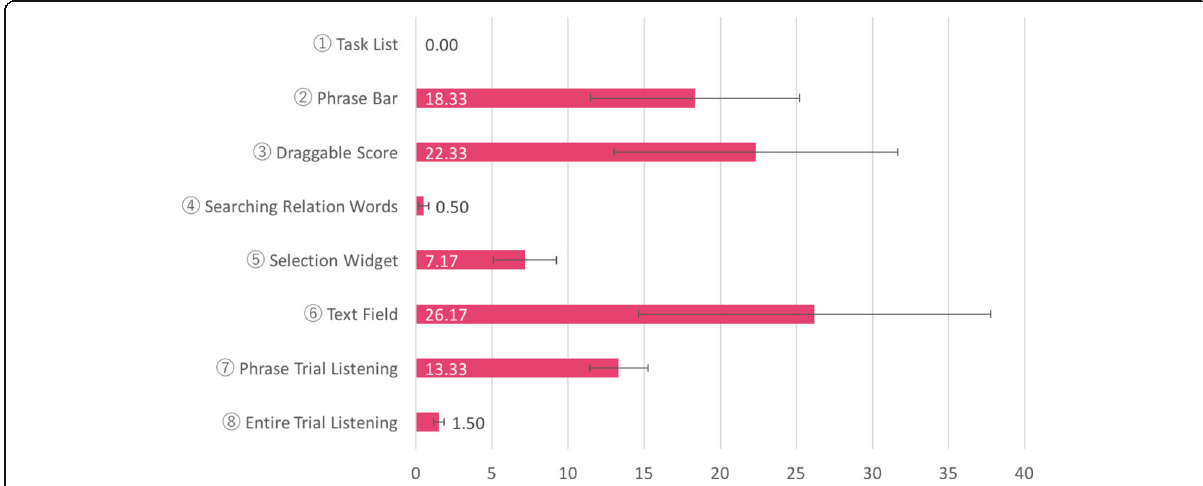
Fig. 11 Result of the average numbers of operations and the standard